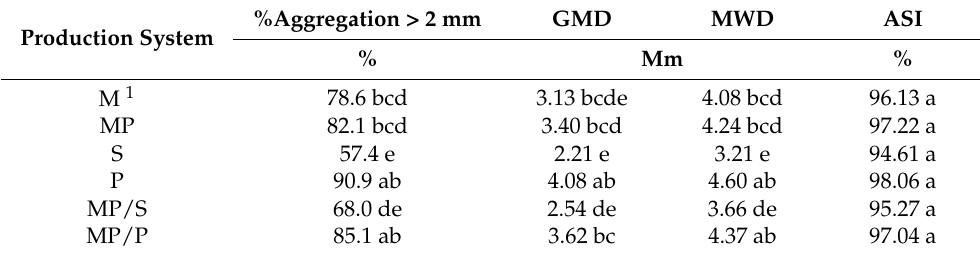
Table 6. Percentage of water-stable aggregates larger than 2.0 mm (%Aggregation > 2 mm), geometric mean diameter (GMD), mean weight-diameter (MWD) and the aggregate stability index